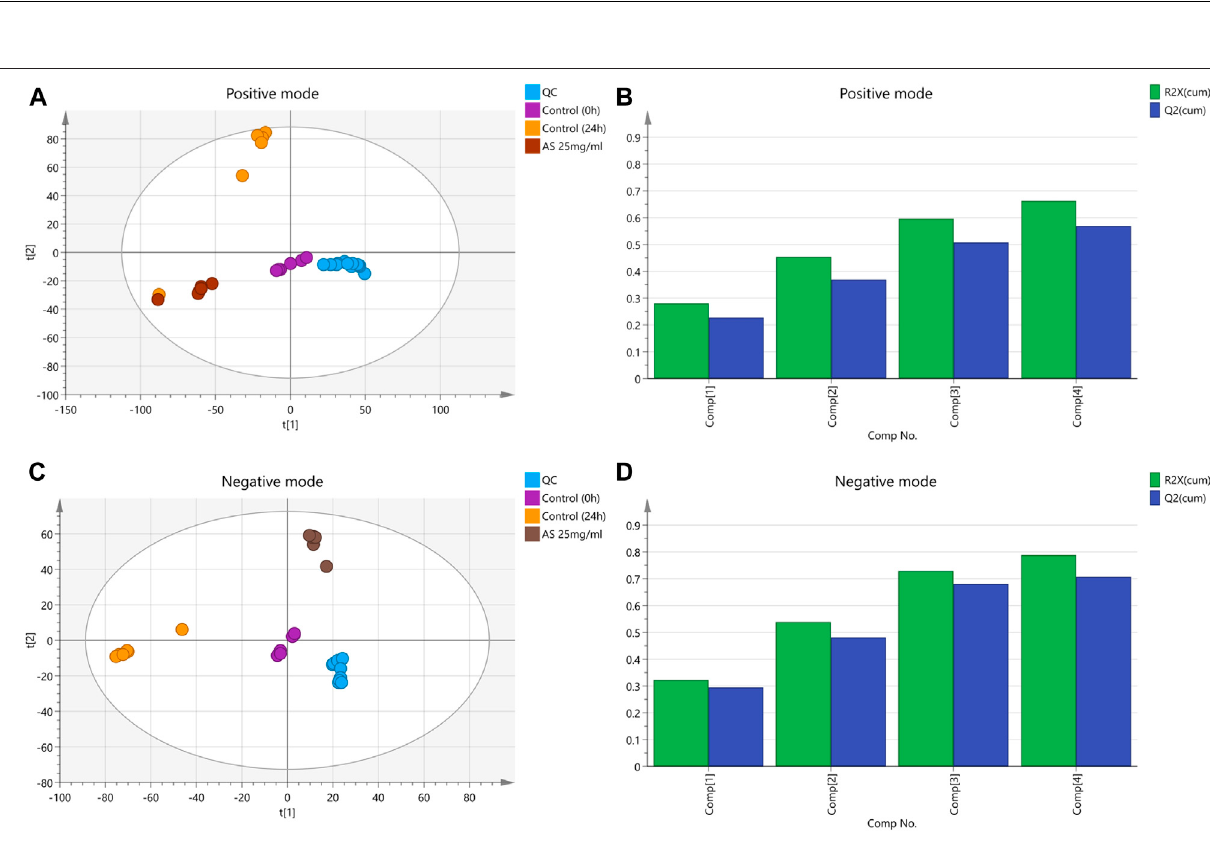
Frontiers in Pharmacology |